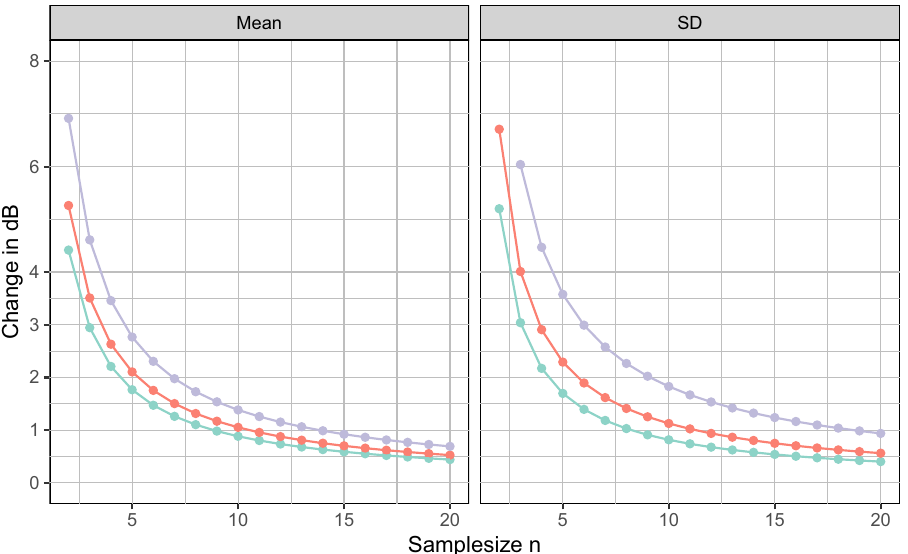
Figure 7. Impact of isolated extreme data in small studies. In a hypothetical future study that includes n samples, a single measurement at the edges of our proposed reference range (see Fig. 6) will affect the mean of the study (left) and the standard deviation (middle) as shown. We are considering the 90%, 95%, and 99% tolerance interval calculated as described in the text. Note that this illustrates a hypothetical experiment as detailed in the